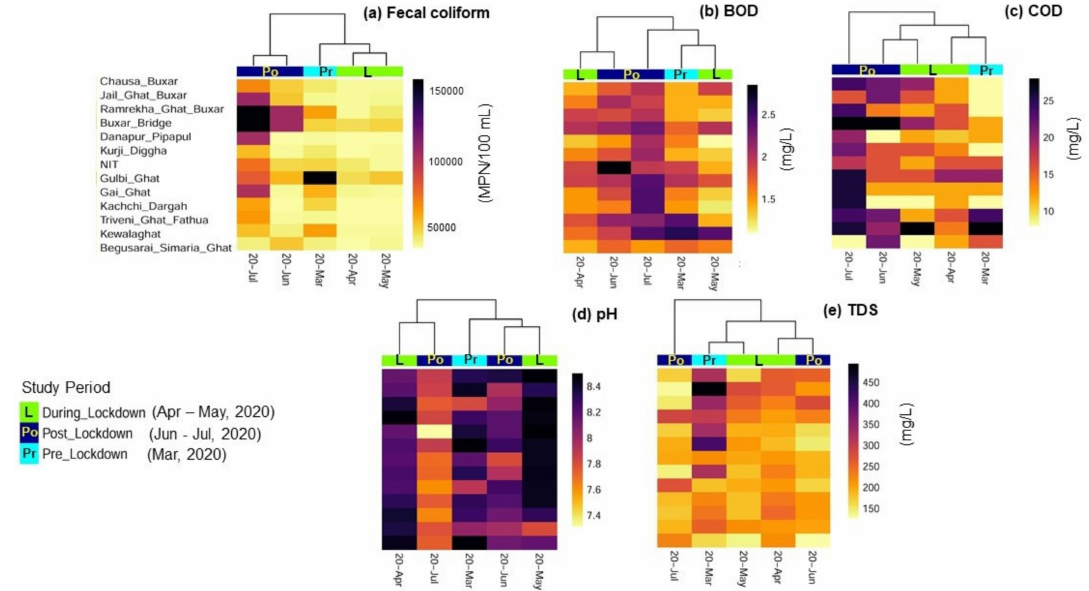
Figure 4. Heatmap of Pearson correlation based on average abundances of ( a ) Fecal content (FC) (MPN/100 mL), ( b ) Biochemical oxygen demand (BOD, mg/L), ( c ) Chemical oxygen demand (COD, mg/L), ( d ) pH and ( e ) total dissolved solids (TDS, mg/L) for the middle reaches of the Ganges river from March to July